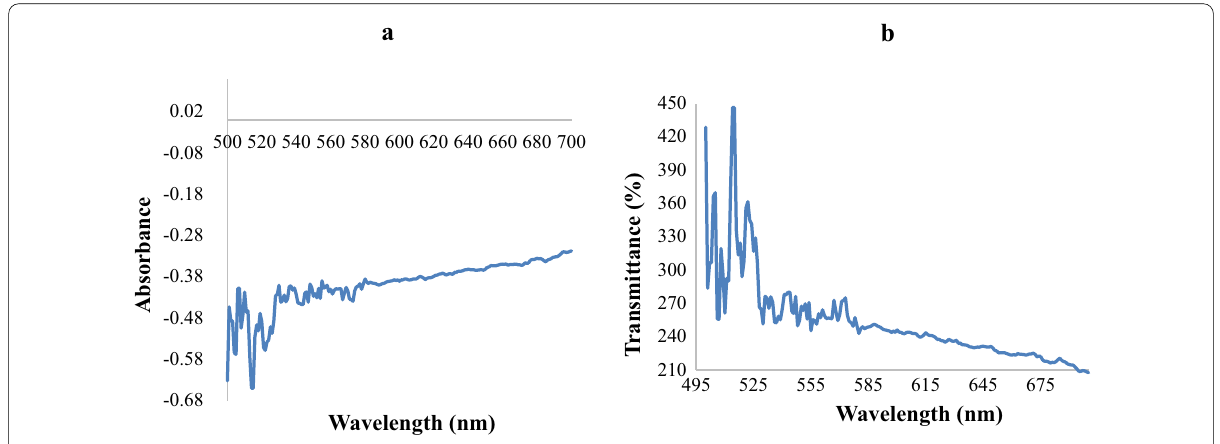
Fig. 1 Effects of absorbance and transmittance of the banana peels